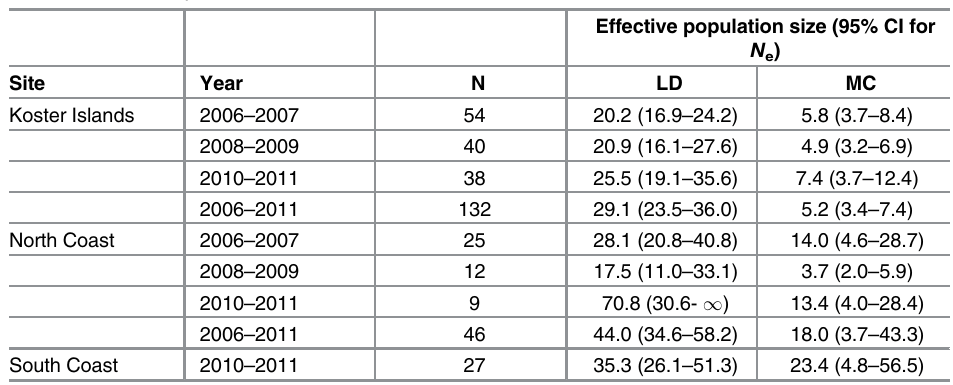
Table 5. Estimates of effective population size ( N e ) derived with different measures for American mink samples collected in the years 2006 – 2011 in Sweden. LN – Linkage disequilibrium method, MC – Molecular coancestry